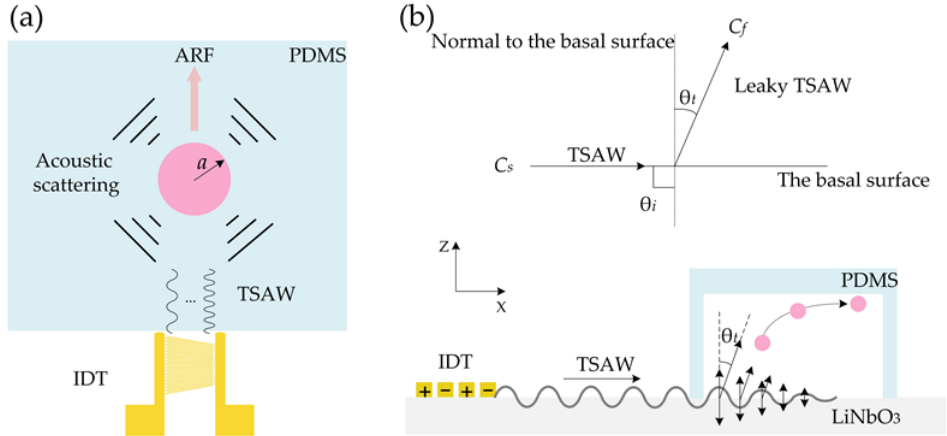
Figure 3. The interaction of TSAW propagating through a fluid with a suspended spherical particle. ( a ) Because of the scattering of TSAW waves on the surface of a spherical particle, ARF is generated and the direction is always the same as the propagation direction of the wave; ( b ) Complex fluid- structure coupling effect between TSAW wave and fluid results in TSAW wave leakage. The leakage TSAW wave propagates in the channel fluid at the Rayleigh angle ( θ t ), driving the particle to achieve the deflection function.